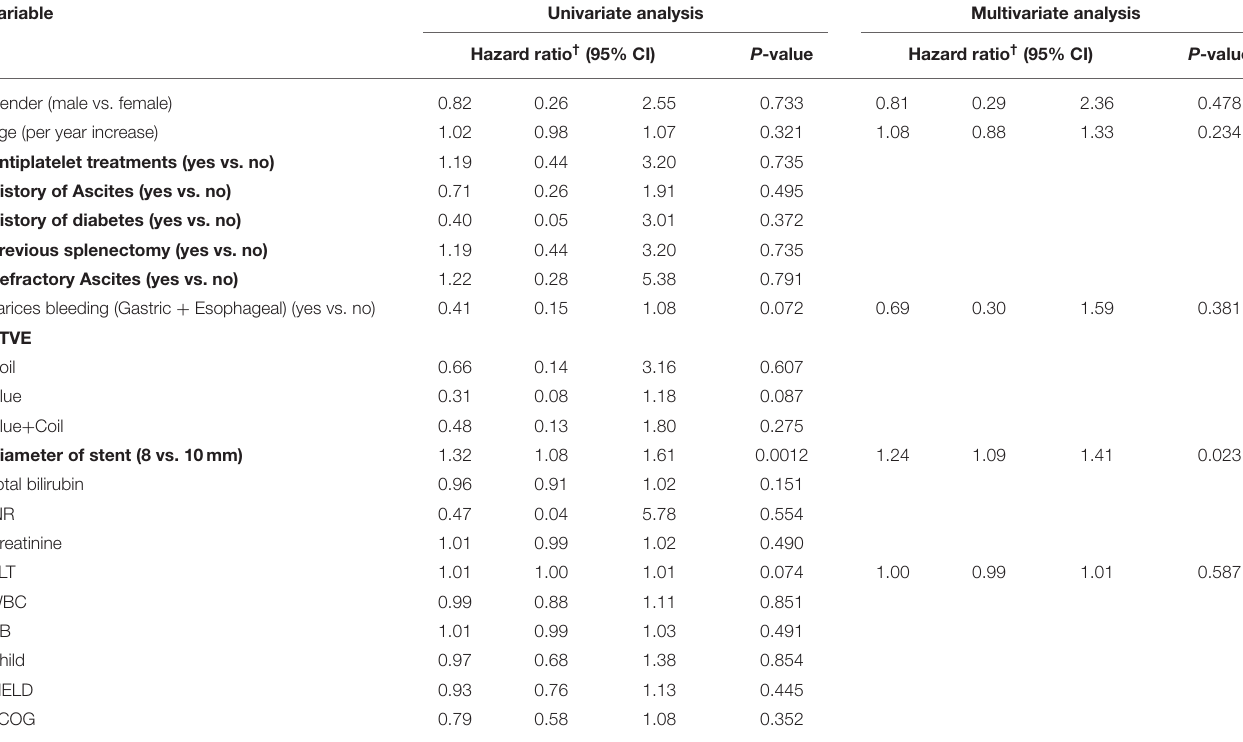
TABLE 4 | Factors associated with risk of shunt dysfunction after Transjugular intrahepatic portosystemic